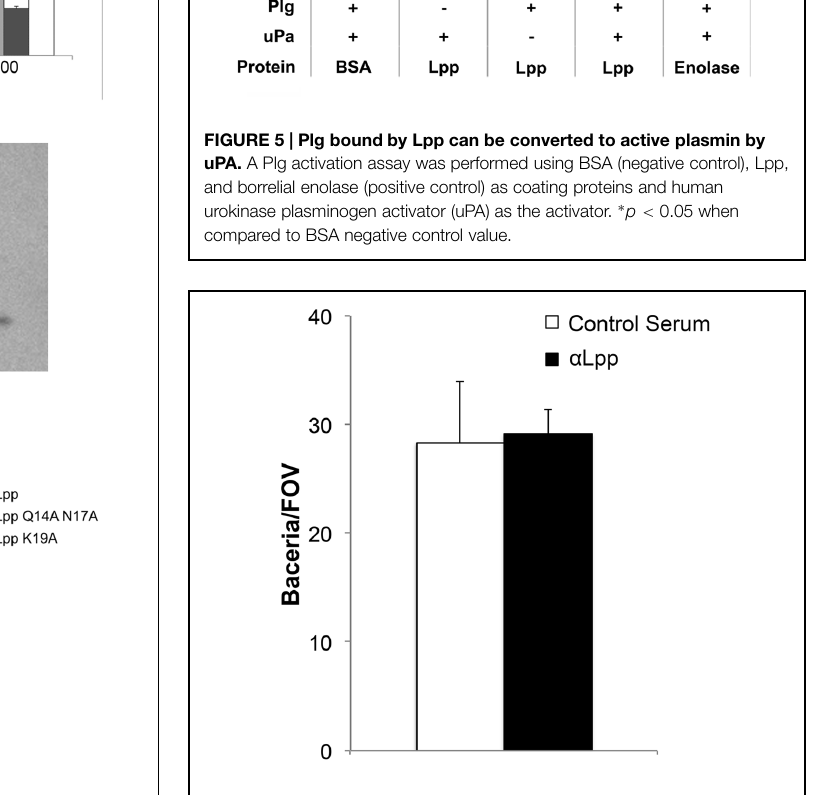
FIGURE 6 | Antibodies against Lpp do not interfere Plg with binding to whole cells. E. coli were treated with α Lpp antibodies or pre-immunized mouse serum (control). Binding was quantitated by bacteria/field of view (FOV) by dark field microscopy. No difference was seen comparing the two groups with regards to Plg